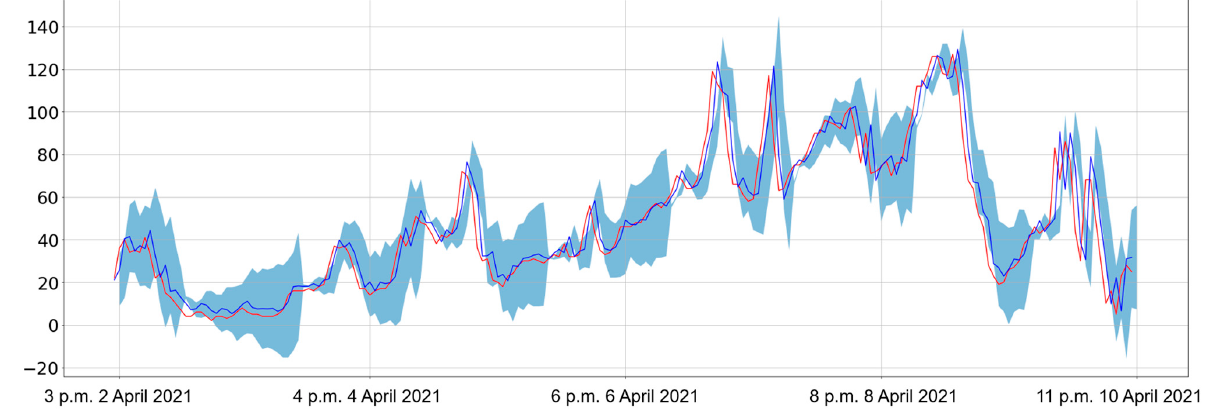
Figure 9. Forecasting results of PM2.5 concentration in Taian.